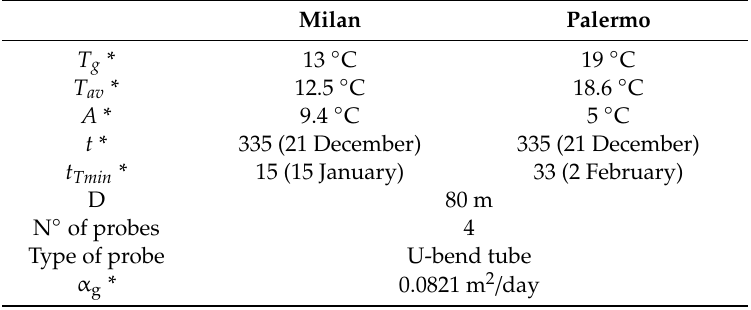
Table 1. Ground temperature and other parameters which a ff ect the energy performance of the ground source heat pump